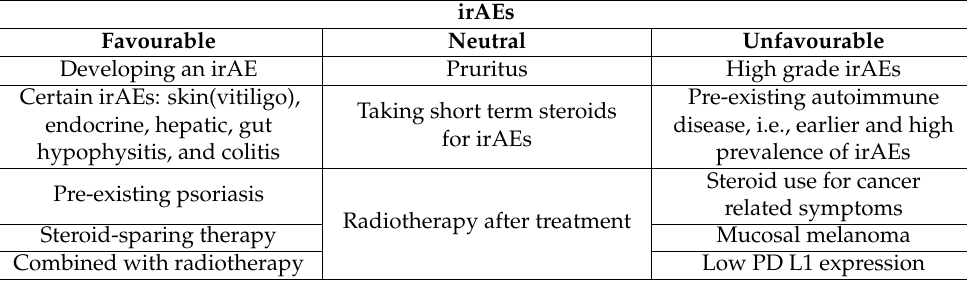
Table 3. Immune-related adverse